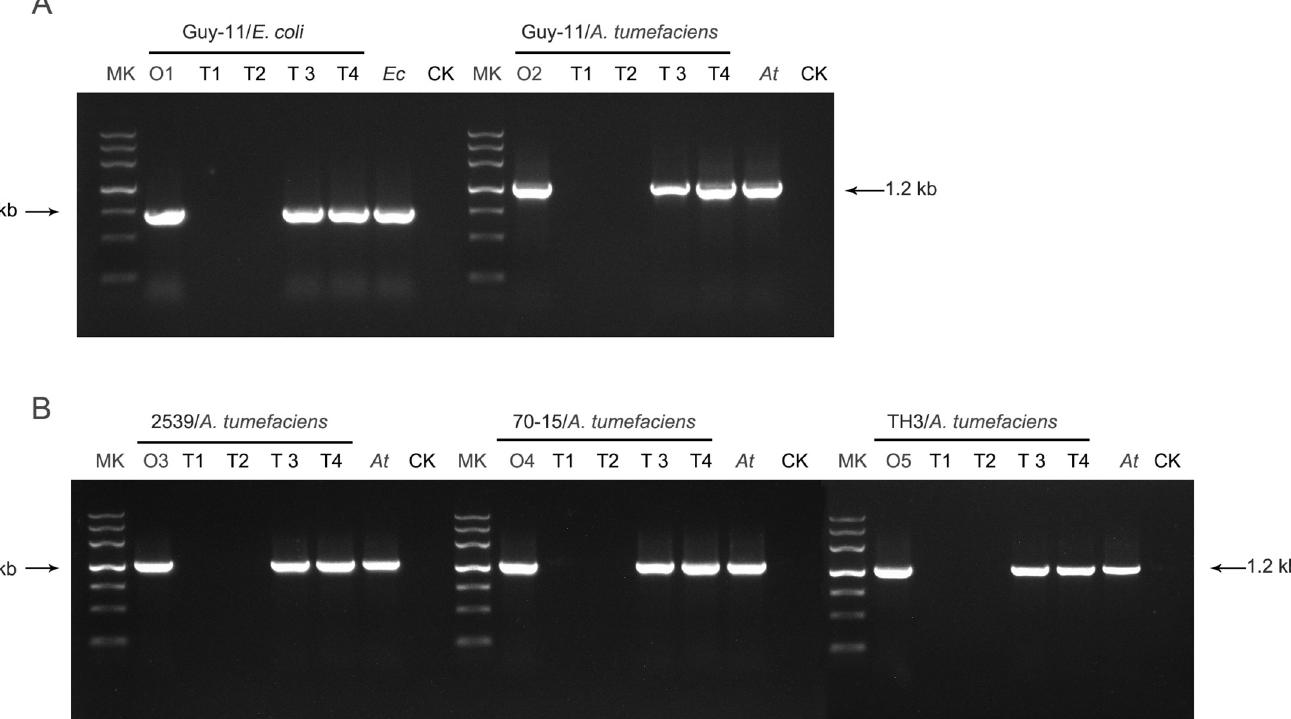
PLOS ONE | https://doi.org/10.1371/journal.pone.0224635 November6,